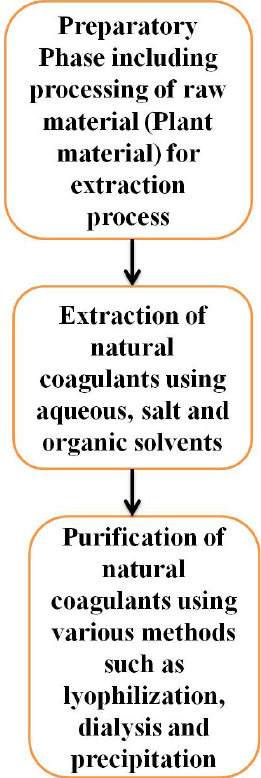
FIGURE 1 - Stages involved in extraction and purification of natural coagulants.